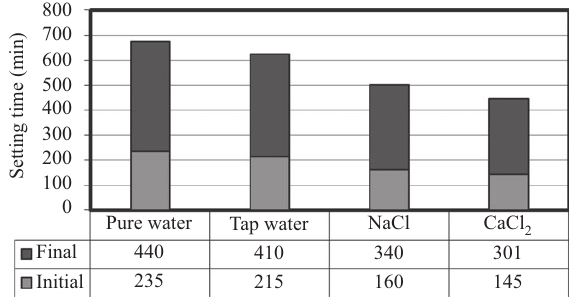
Figure 5 Setting time of the mixtures.